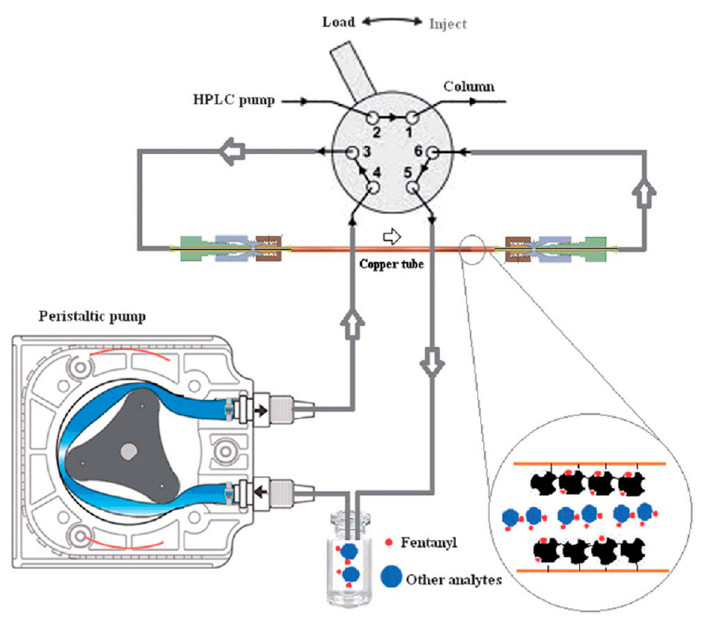
Figure 2. On-line capillary tube connected to HPLC [39].